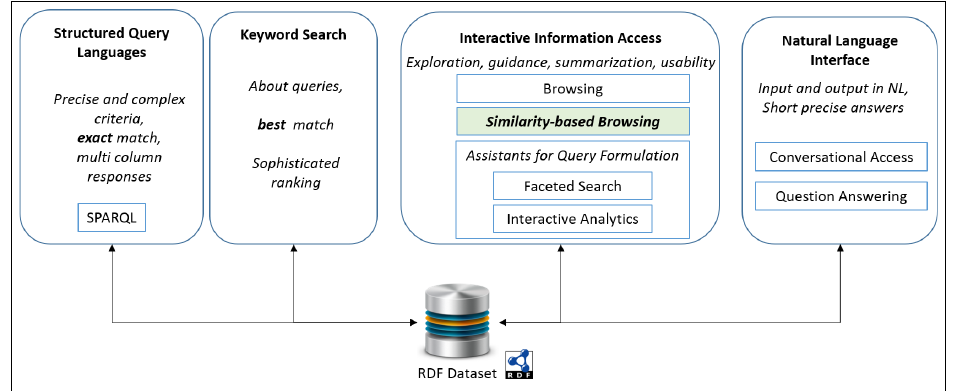
Figure 1. An Overview of Access Methods over